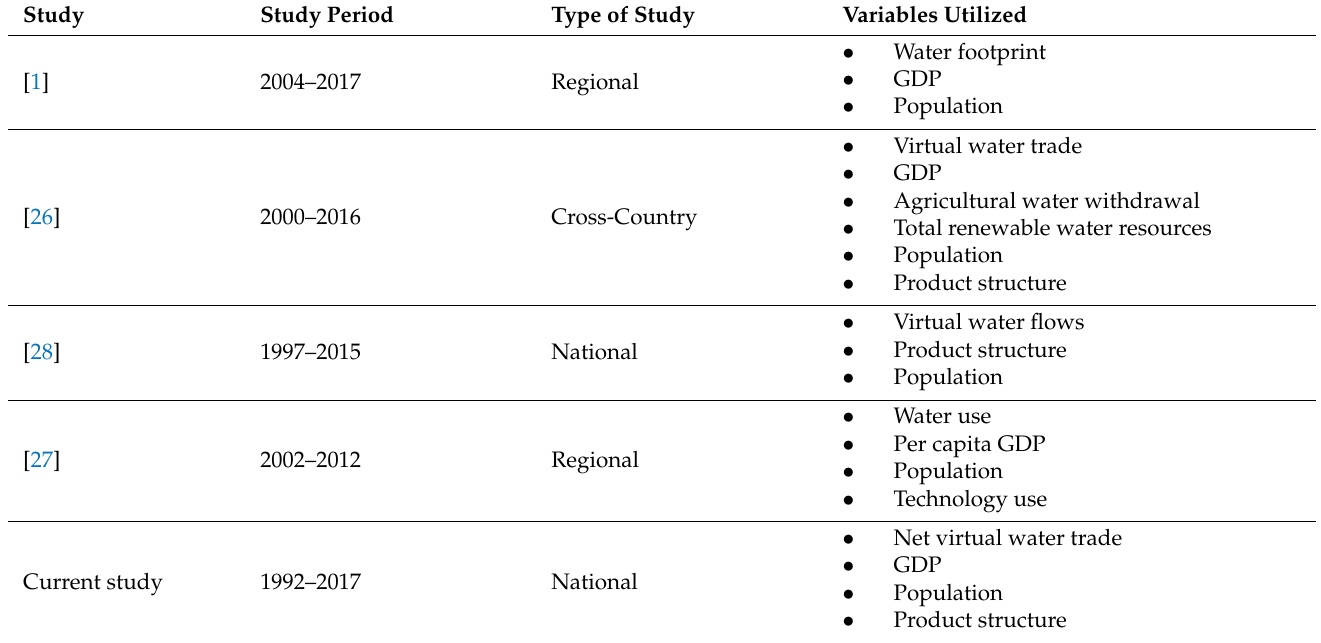
Table 1. Previous and current logarithmic mean divisia index (LMDI) studies in water